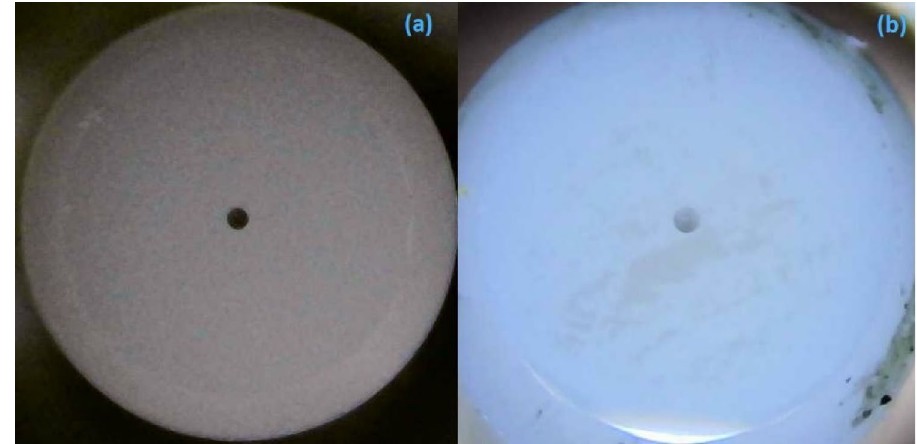
Figure 1. Fiber ferrule ( a ) without SA and ( b ) with ZnO thin film deposit using